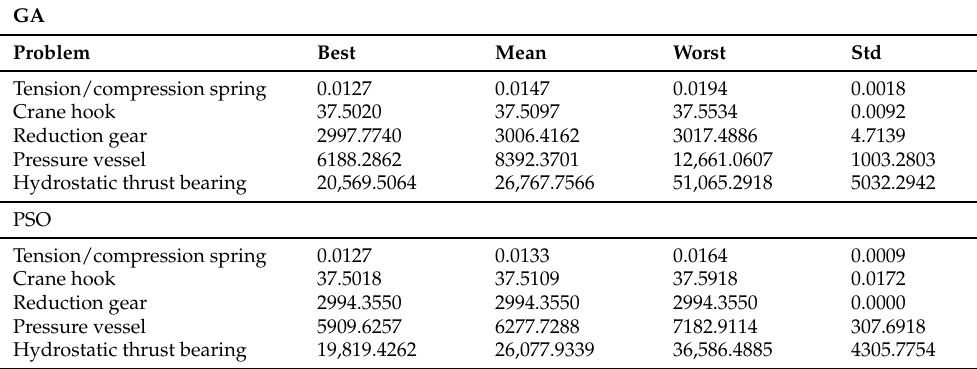
Table 13. Statistical findings of the GA and PSO for the selected design